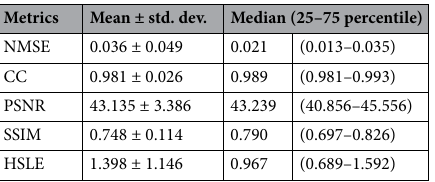
Table 2. Summary of testing the method over a synthetic dataset.